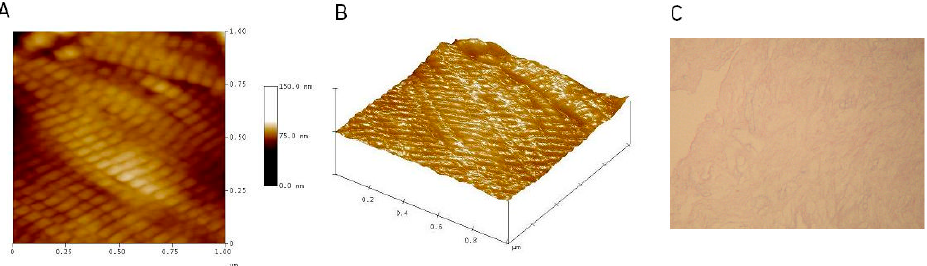
Figure 1. Human acellular dermal matrix (ADM) images: ( A ) atomic force microscopy (AFM), “Height” image; ( B ) atomic force microscopy (AFM), “3D” image; ( C ) H&E